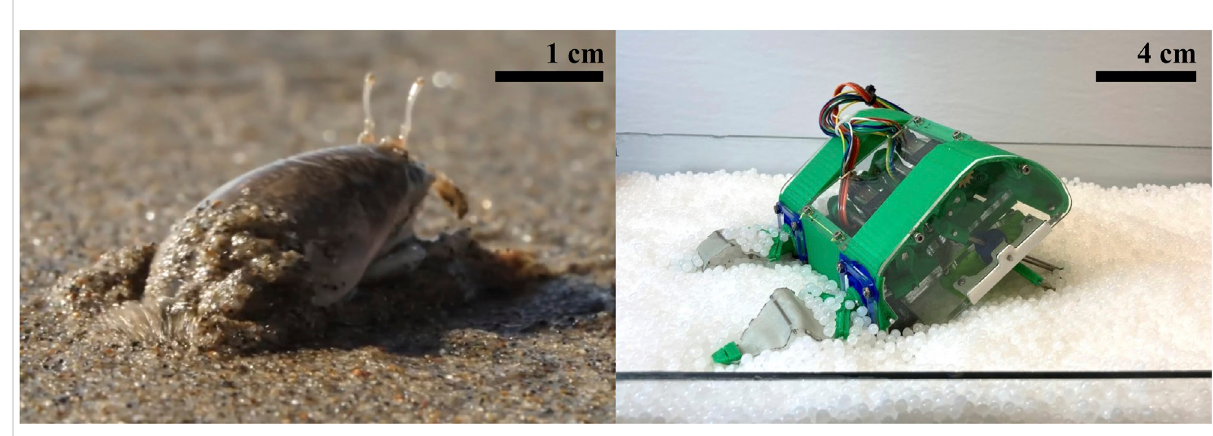
FIGURE 1 Paci fi cmolecrab-InspiredRobot.Imageof Emeritaanaloga initsnaturalsubstrate,contrastedwiththemolecrab-inspiredrobotEMBURinthe substrate used for testing. Left-hand Image by Josh Cassidy (KQED), right-hand image by Laura